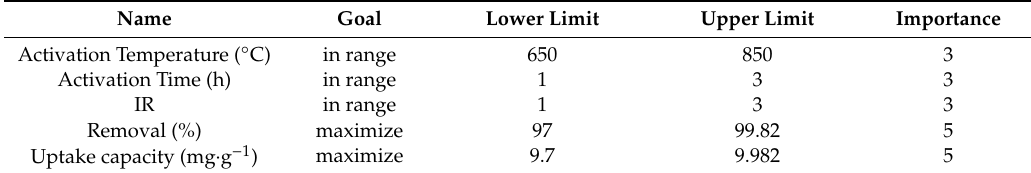
Table 6. Constraints for optimization process based on central composite design (CCD) for bio-powder activated carbon (bio-PAC)